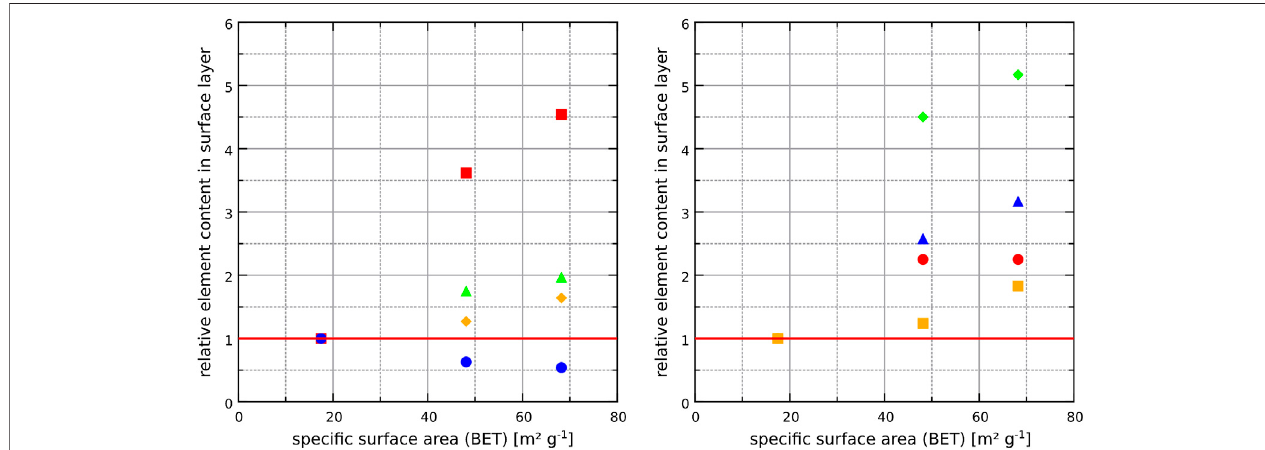
FIGURE6| Effectofthespeci fi csurfaceareaofthesurfacelayerontherelativeelementcontents(measuredbyICP-OES,wt%)forsamplesthatwerestoredinthe sodiumsulfatesolution.Thesevaluesarenormalizedtothecontentsofelementsforsample18_SO4(speci fi csurfacearea(N 2 -BET)of17.5 m 2 g − 1 ).Therelativecontents ofseveralelementsappearedtocorrelatewiththespeci fi csurfacearea,indicatingthattheyarepreferablyincorporatedinphaseswithlargerspeci fi csurface.Amongthe major elements, the effect is most prominent for magnesium, indicating the formation of Mg-rich LDH phases. For minor elements, the effect is most prominent for manganese. Left fi gure: Al ( ▲ ), Mg ( ■ ), Ca ( C ), Si ( ◆ ). Right fi gure: Ti ( ▲ ), Ba ( C ), Mn ( ◆ ), Fe ( ■ ).